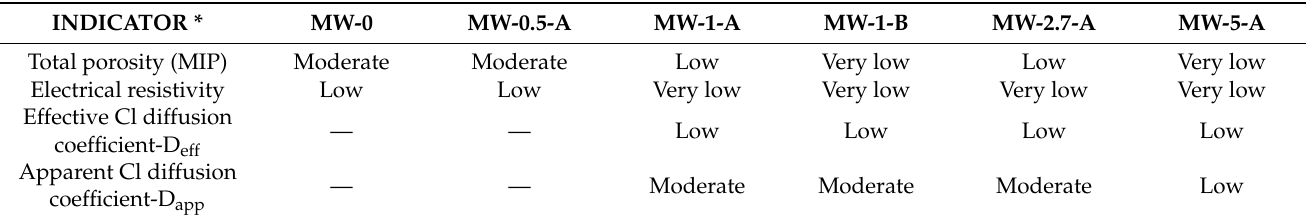
Table 4. Potential durability of the different mixes in this research according to the limits given in [46].